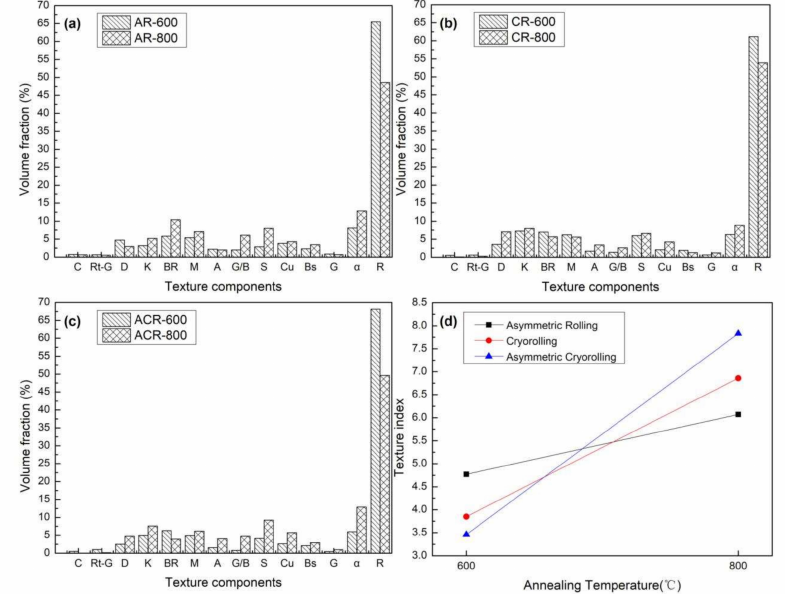
Figure 5. Variation of texture components with annealing temperature in ( a ) asymmetrically rolled CoCrNi MEA, ( b ) cryorolled CoCrNi MEA ( c ) asymmetric cryorolled CoCrNi MEA; ( d ) comparison of the variation of texture index with annealing temperature between asymmetrically rolled, cryorolled and asymmetric cryorolled CoCrNi